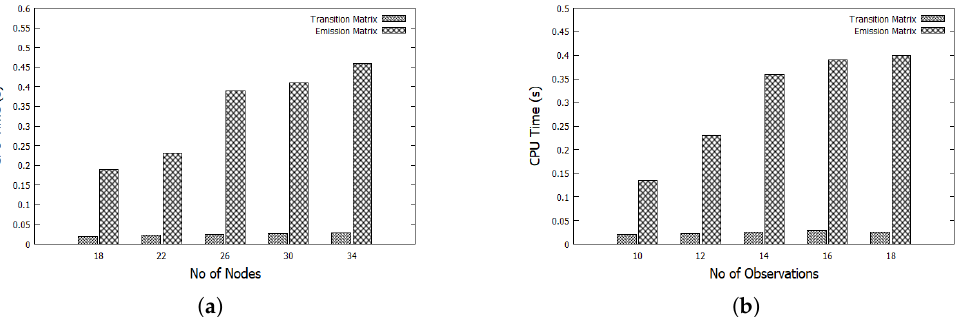
Figure 6. Effects of varying number of nodes and number of observations on CPU time of constructing the Transition matrix and Emission matrix: ( a ) varying number of nodes; ( b ) varying number of